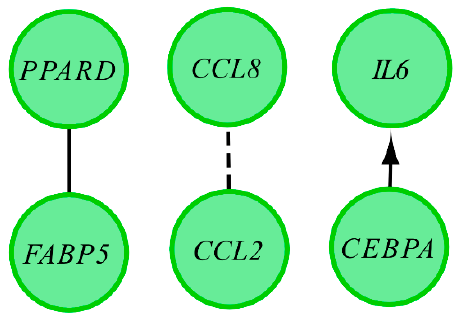
Figure 8. Functional interaction (FI) between 20 chosen differently expressed genes that belongs to the anatomical structure development, biological adhesion, developmental process, negative regulation of cell proliferation, regulation of cellular component organization, single − multicellular organism process, and single − organism cellular process GO BP terms. In the following figure, “->“ stands for activating/catalyzing, “-|” for inhibition, “-” for FIs extracted from complexes or inputs, and “---” for predicted FIs.